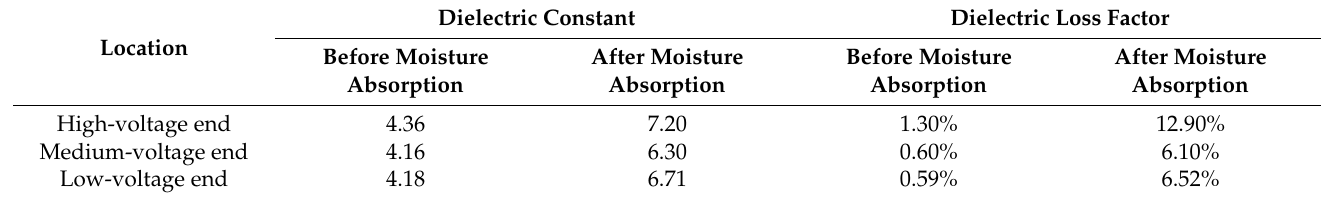
Table 4. Dielectric constant and dielectric loss factors of test pieces before and after moisture